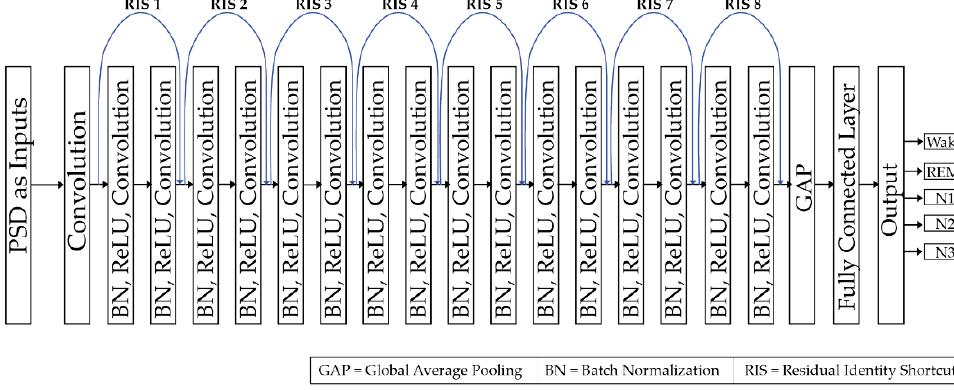
Figure 4. Block diagram of the proposed architecture.